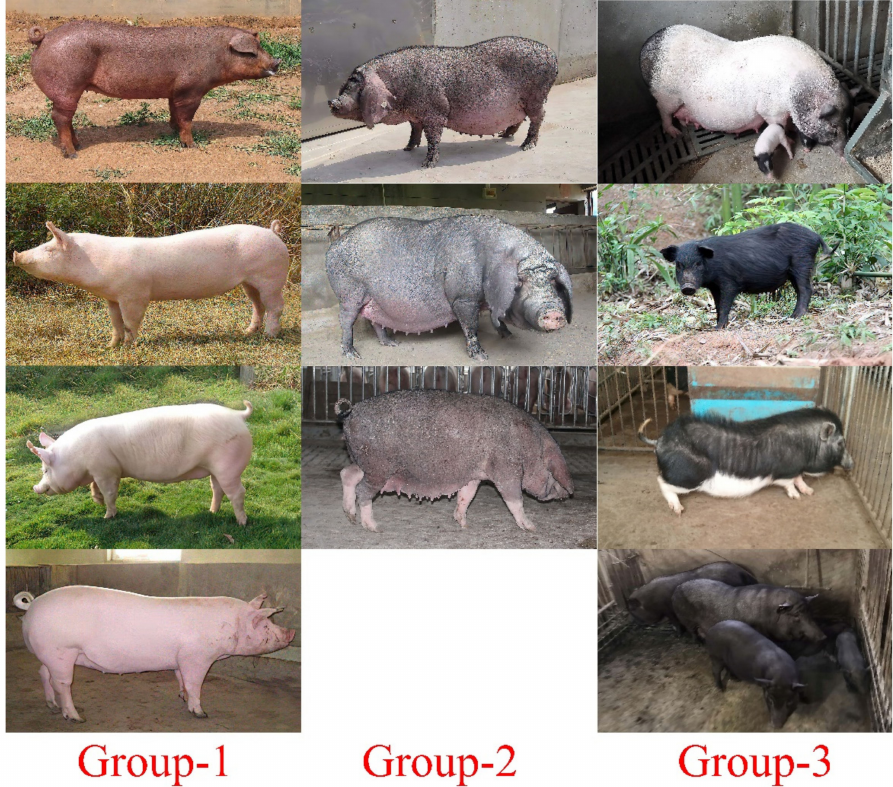
Figure 1. Different coat-color pig breeds. In Group-1 , from top to bottom is Duroc, Landrace, Large White, and SuShan, respectively. In Group-2 , from the top down is FengJing, Erhualian, and Meishan, respectively. In Group-3 , from top to bottom is Bama, Tibetan, Wuzhishan, and Banna, respectively.